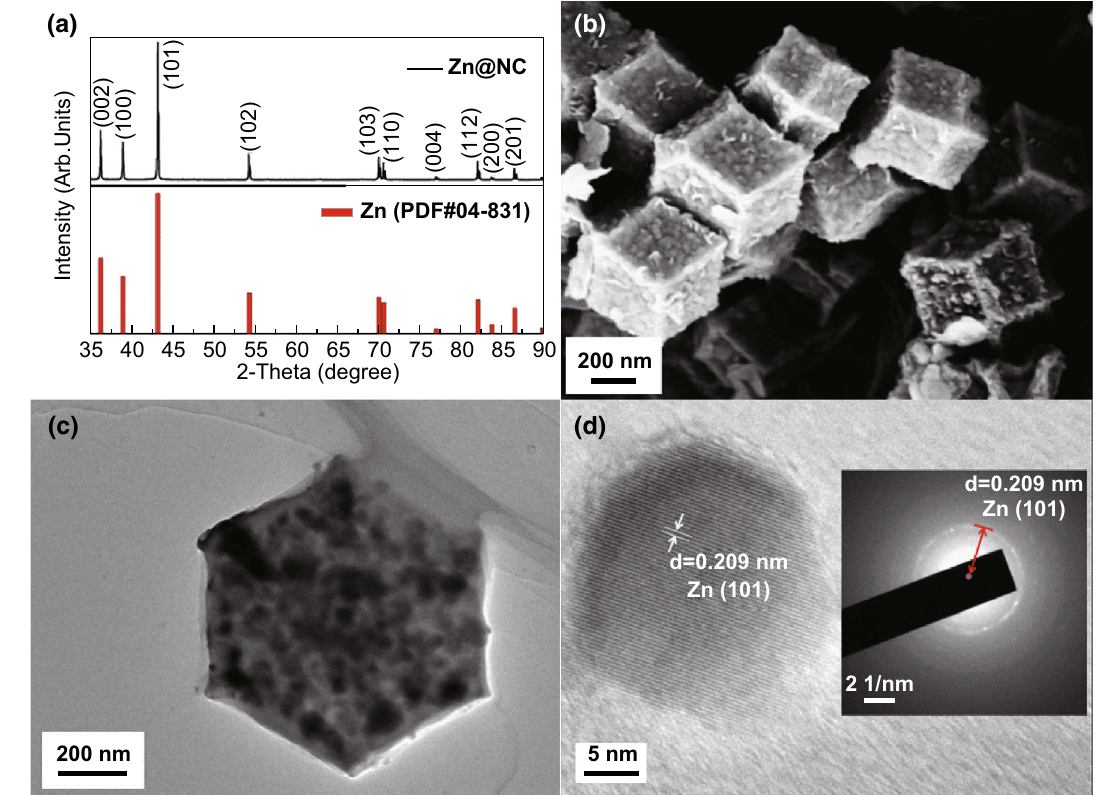
Fig. 4 a XRD pattern, b SEM, c TEM, and d HRTEM and SAED images of